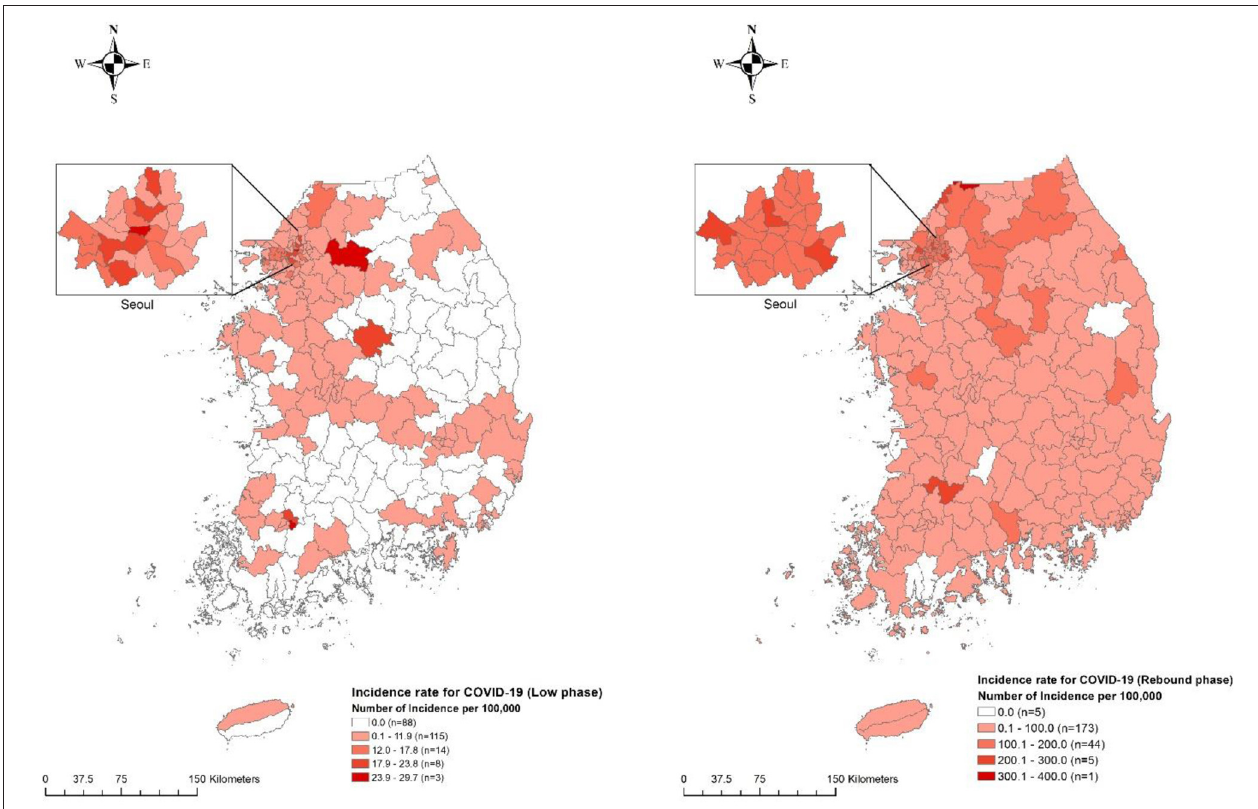
FIGURE 2 | Geographical distribution of municipality-specific incidence rate for COVID-19 in Korea between two epidemic phases. The number of incidences for COVID-19 per 100,000 inhabitants at the municipality level is denoted by five different color levels in the low phase of COVID-19 ( left ) and rebound phase of COVID-19 ( right ). Darker red shedding represents the highest strata, whereas brighter red shedding denotes the lowest strata along with white color representing